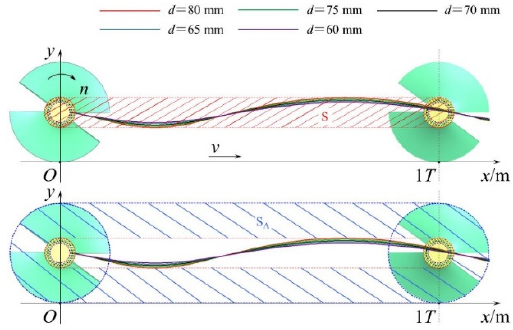
Figure 10. The motion trajectory of the spiral shaft under different d values. Note: d is the DSS, mm. S is the ineffective operation area of the SSM, mm 2 ; S A is the effective operation area of the SSM, mm 2 ; n is the RVSS, rpm; v is the operating velocity of machines, km/h. The calculation method of η was shown in Equation (11). It could be seen from the above analysis that the operating velocity of machine v = 1.3889 m/s, and when the RVSS n = 110 rpm, the cycle T = 1/ n = 0.5455 s. Substitute the DSS d ∈ [60, 80] into Equation (11). The calculation results of the ineffective operation area S, the effective operation area S A and the ineffective operation rate η of the SSM with different values of the DSS d are shown in Table 3. As the DSS d increases from 60 mm to 80 mm, the ineffective operation rate η